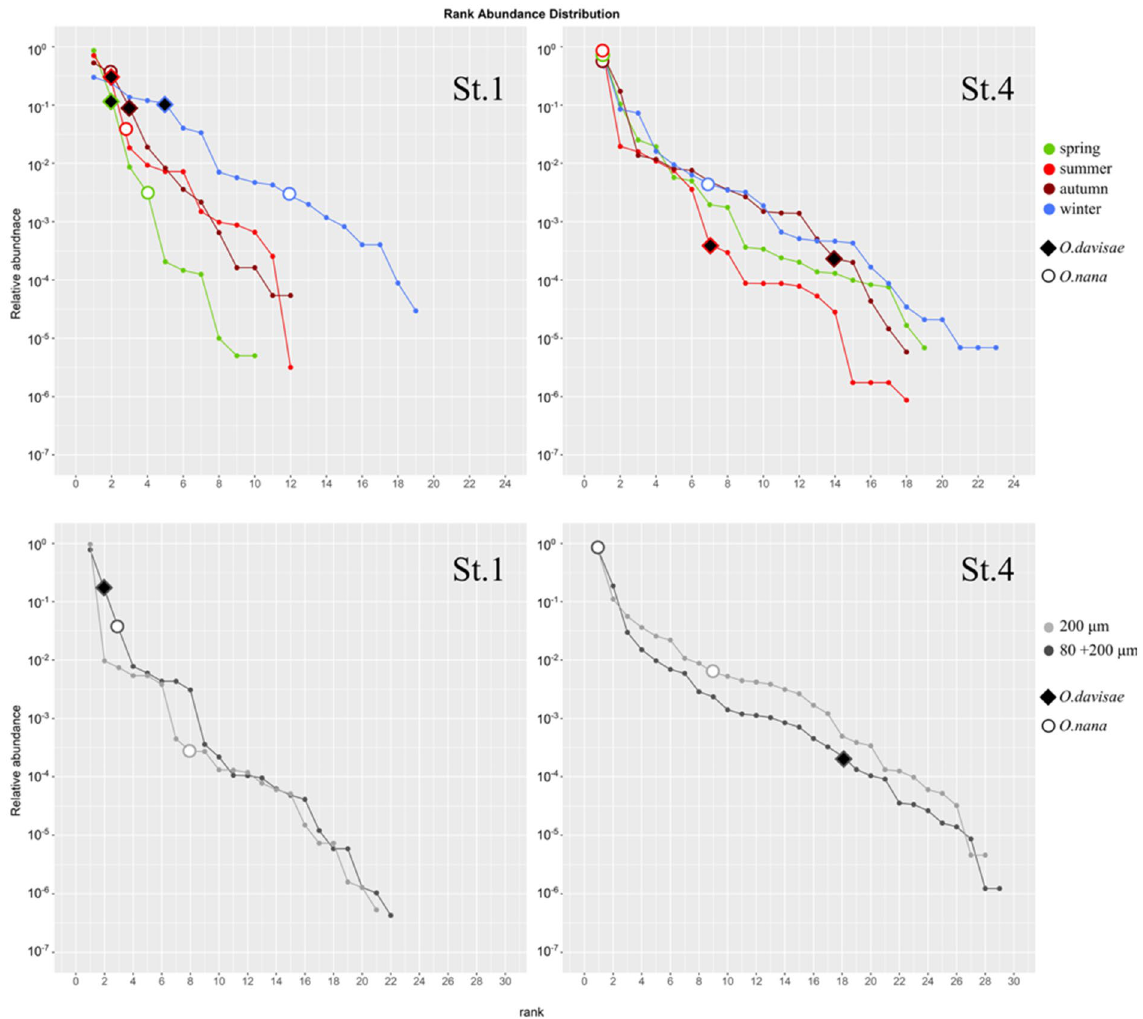
Figure 5. Upper panels: Synthetic Rank Abundance Distributions of the copepod community divided by seasons of St.1 and St.4 obtained by merging the data sampled with 200 μm mesh net over the period 2014–2017 and the data of monthly sampling (12 months) with the 80 μm mesh (2016–2017). Lower panels: Synthetic Rank Abundance Distributions of the copepod community of St.1 and St.4 comparing data of 200 μm mesh size only and data of merged data of 80 μm and 200 μm over the period 2014–2017. The ranks of the Oithona davisae and Oithona nana are